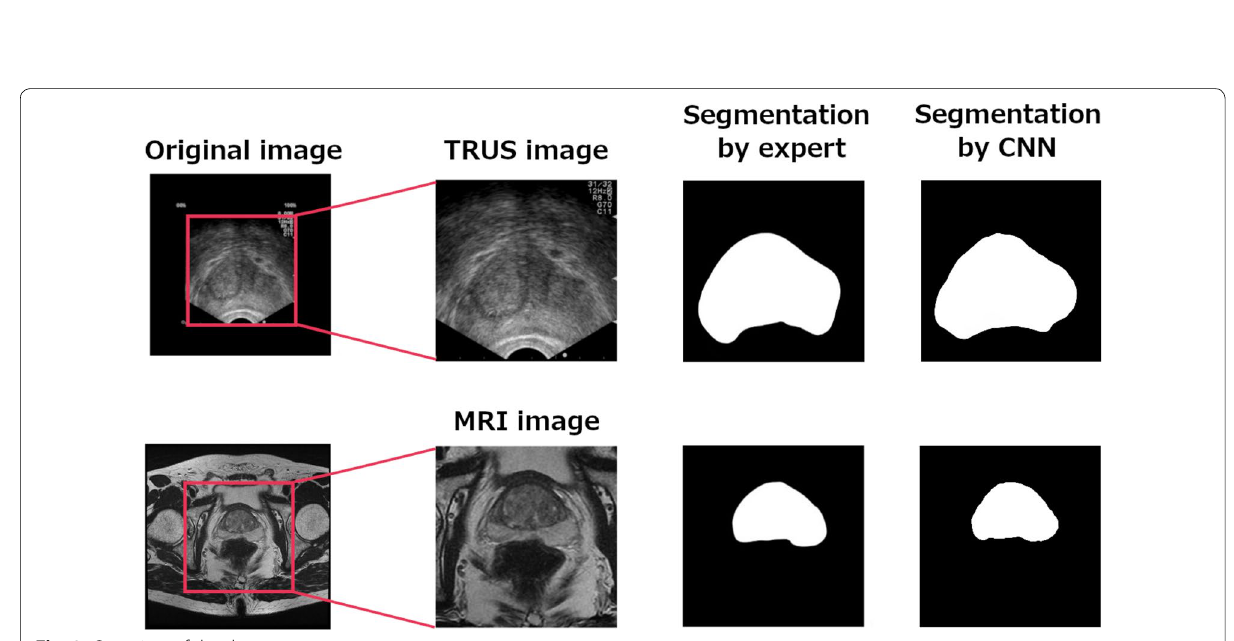
Fig. 2 a Aligns the MR-TRUS to the same image scale and pole-transforms the prostate contour to calculate the error of the radial distance between the two contours. b The MR image having the smallest error is an image corresponding to the TRUS image